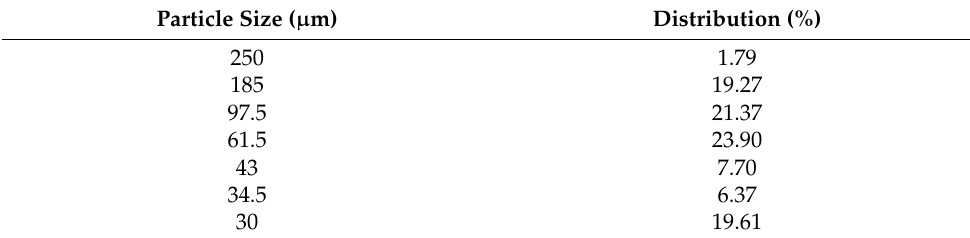
Table 3. Gradation distribution of